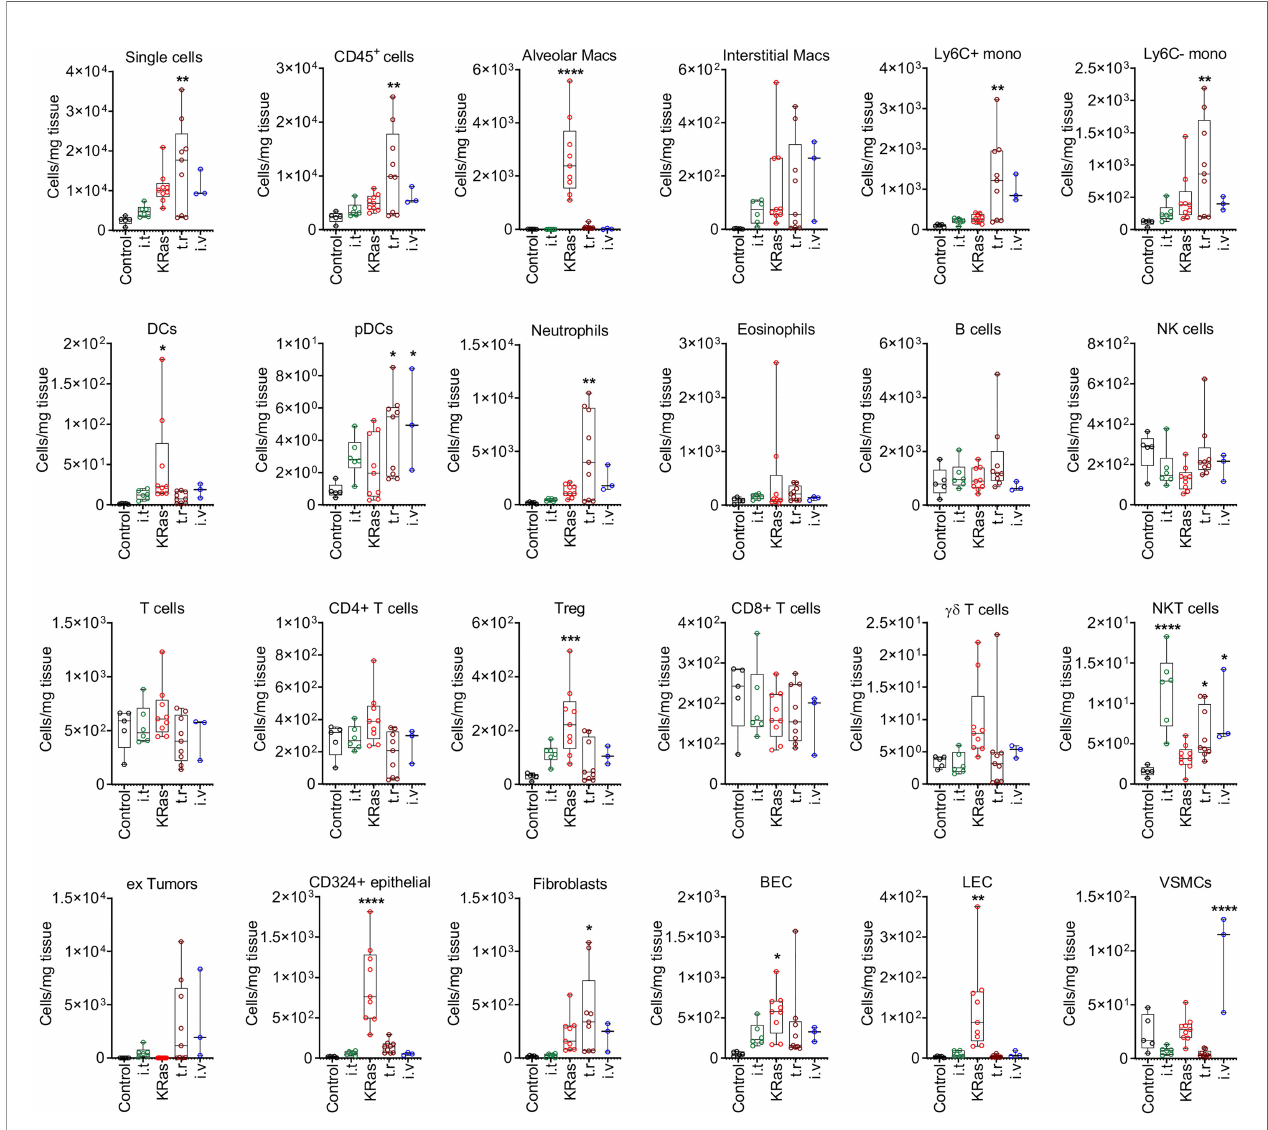
FIGURE 5 | Quantitative distribution of pulmonary cells in different lung tumor models. Cell numbers (per 1 mg of tissue) determined by FACS analysis in healthy control lung and cancerous lungs from four different models are shown. Control means healthy lung. i.t., intratracheal injection; i.v., intravenous injection; t.r., tumor relapse model; Macs, macrophages; Mono, monocytes; DCs, dendritic cells; pDCs, plasmacytoid dendritic cells; NK cells, natural killer cells; NKT cells, natural killer T cells; Treg, regulatory T cells; BECs, blood endothelial cells; LEC, lymphatic endothelial cells; VSMCs, vascular smooth muscle cells. Numbers of mice by group: control n=5, for i.t. model n=6, for KRas model n=9, for tumor relapse model n=9, for i.v. model n=3. *P < 0.05, **P < 0.01, ***P < 0.001, ****P < 0.0001 compared with